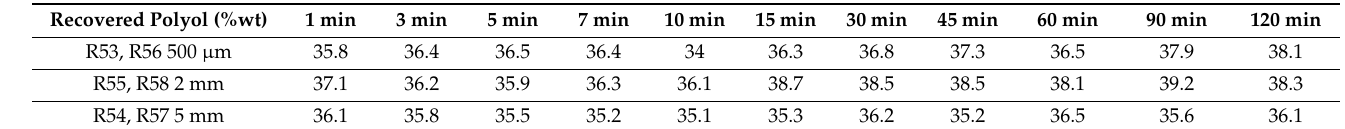
Table 4. Concentration in percentage of each of the components of the product of the reactions R53,